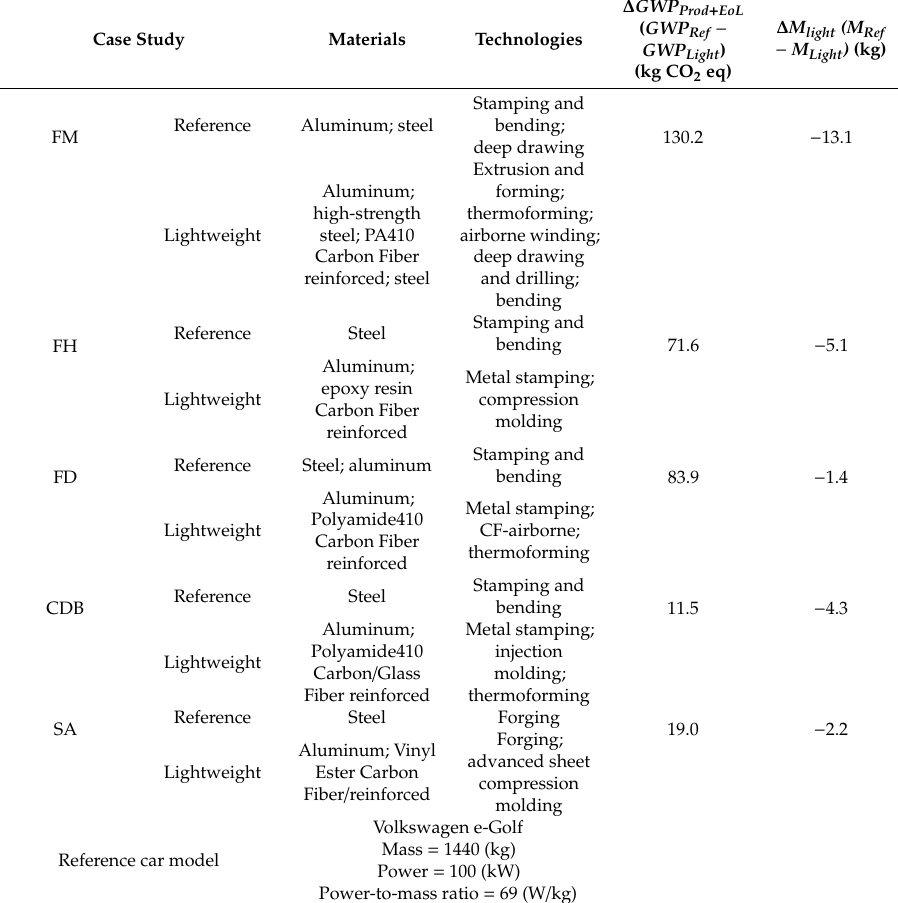
Table A4. Main technical and sustainability features of the considered sustainability case studies.